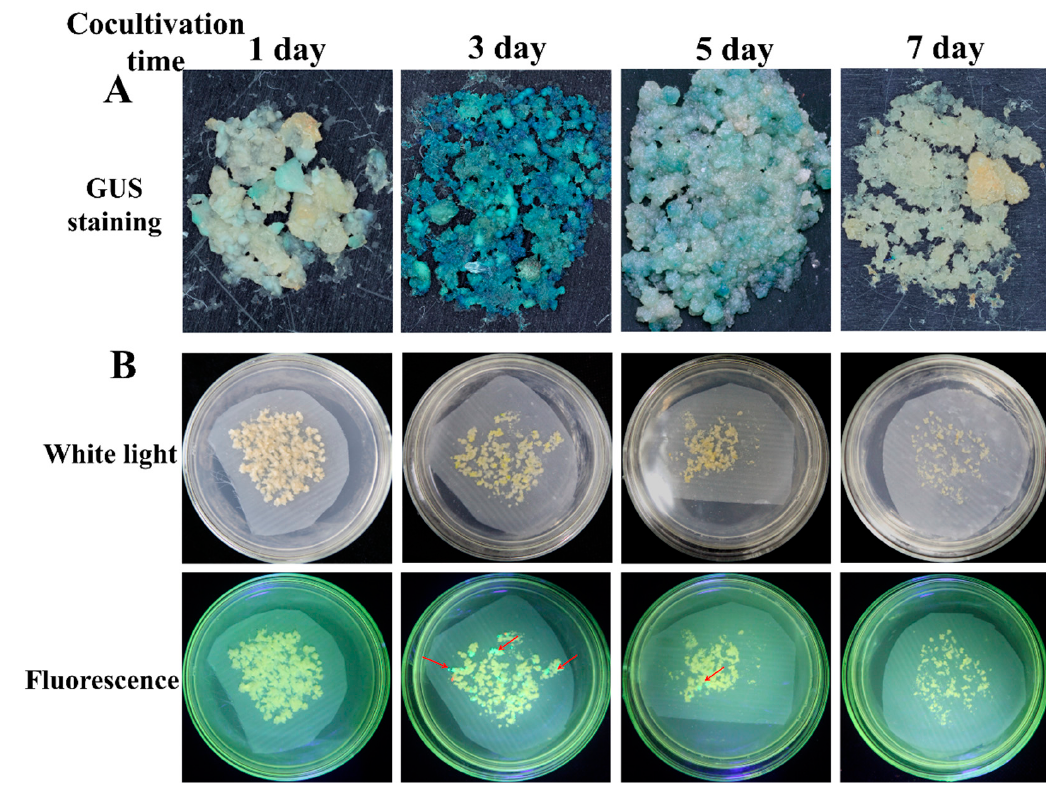
Figure 3. Stable expression of GUS in FECs ( A ) and GFP in cotyledons ( B ) under different coculti- vation days. ( A ) GUS staining of FECs. FECs were taken from the last time on GD medium plates. After GUS staining, pictures were taken under an ultradeep field microscope. ( B ) Cotyledons on MSN medium under white light and fluorescence. Red arrows point to somatic embryos with green fluorescence. Table 3. Effects of cocultivation period on cassava SC8 transformation.